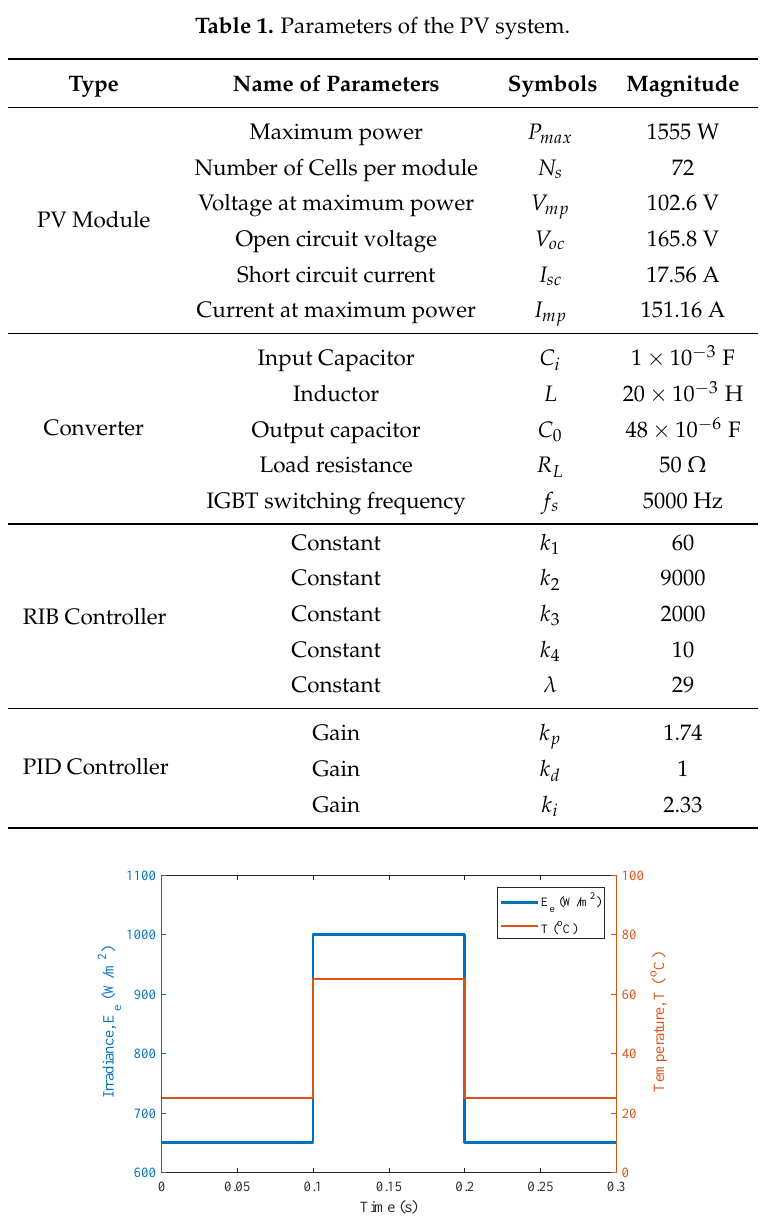
Figure 7. Irradiance and temperature